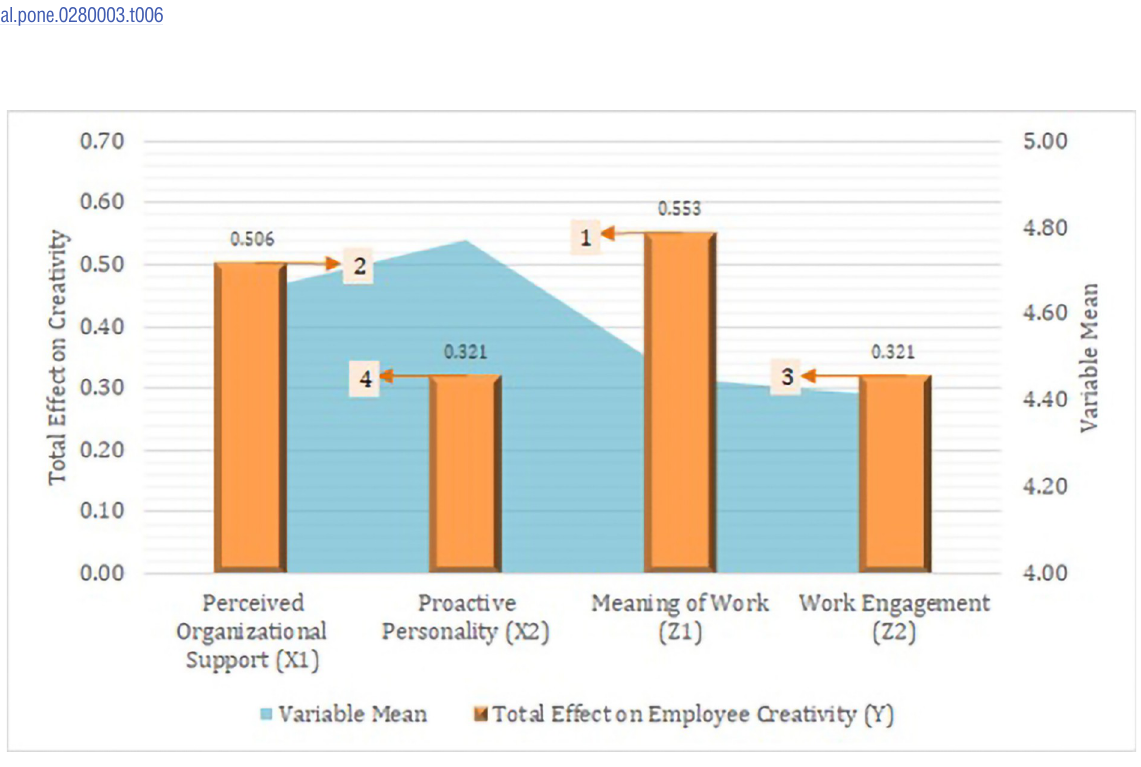
Fig 3. Total effect on employee